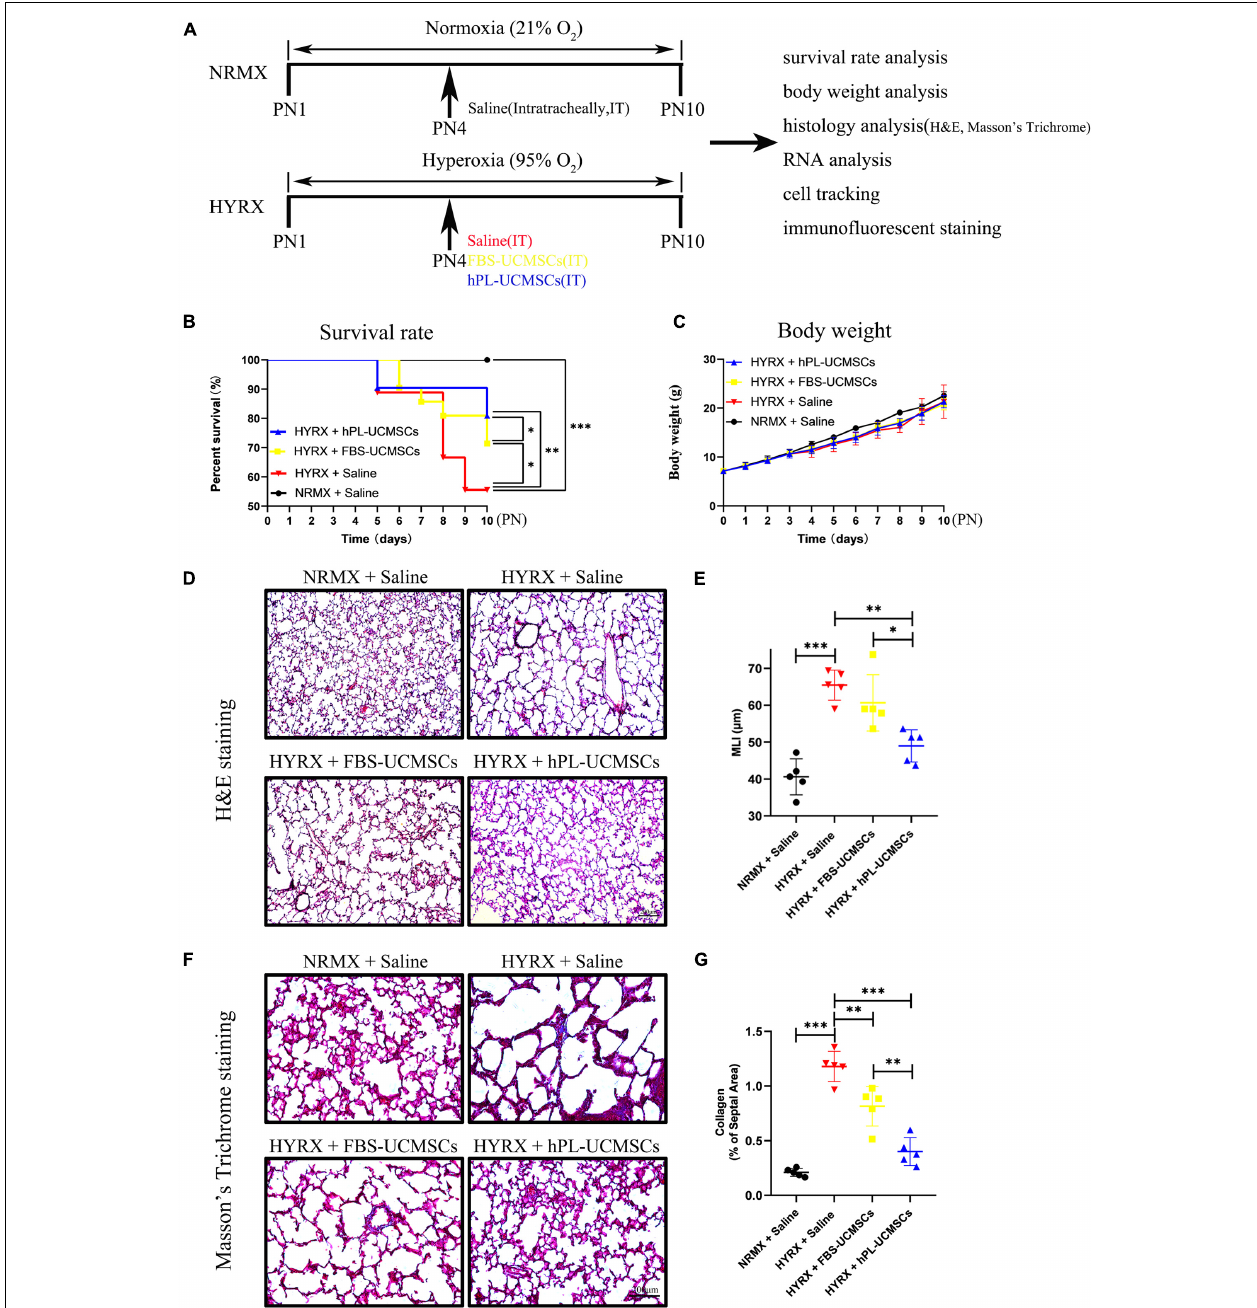
FIGURE 4 | Superior therapeutic effects of hPL-UCMSCs versus FBS-UCMSCs on lung restoration in BPD model. (A) Schematic of protocols used for model establishment, administration of saline and UC-MSCs, and function analysis. During PN1 to PN10, the survival rate (B) and body weight (C) in each point were recorded among saline and UC-MSCs (FBS-UCMSCs or hPL-UCMSCs) treatment group. Rat lung tissue were harvested at PN10 and lung sections were stained with H&E (D) . Scale bars, 200 µ m. Quantification of mean linear intercept (MLI) in each group represents a surrogate of average air space diameter (E) . Collagen deposition of lung sections were assessed by staining for Masson’s trichrome (F) . Scale bars, 200 µ m. Collagen deposition was used as surrogate of fibrosis and was reported as percent of septal area (G) . Data are shown as mean ± SEM. n = 5–10. ∗ p < 0.05, ∗∗ p < 0.01, ∗∗∗ p < 0.001.